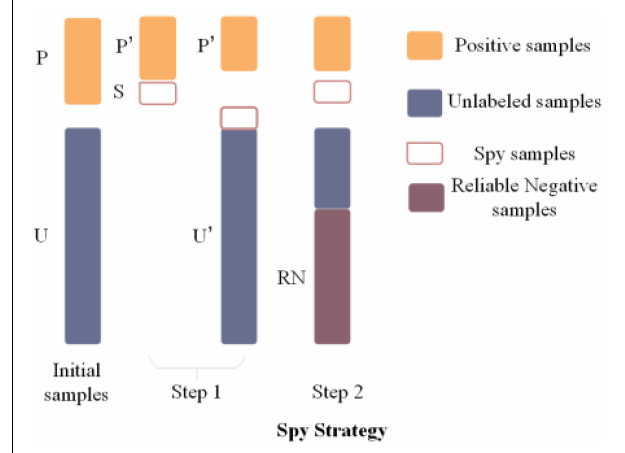
FIGURE 3 | Flowchart of Spy